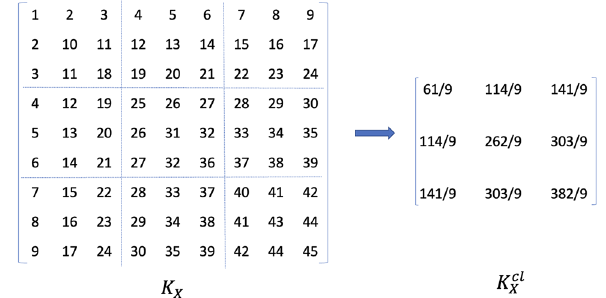
Figure 1. Illustration for K cl X when N = 9 and m = 3 .